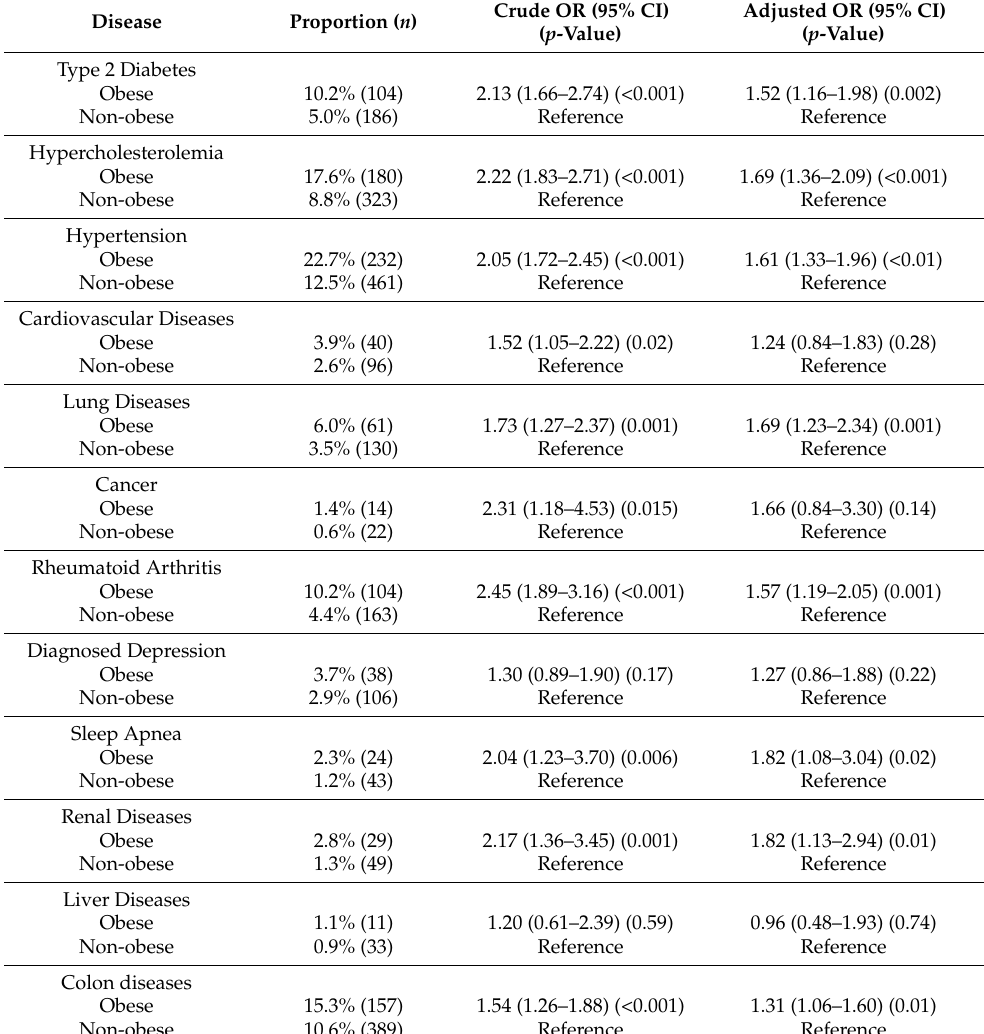
Table 3. Crude and adjusted odds ratio (OR) for the association between obesity and different chronic